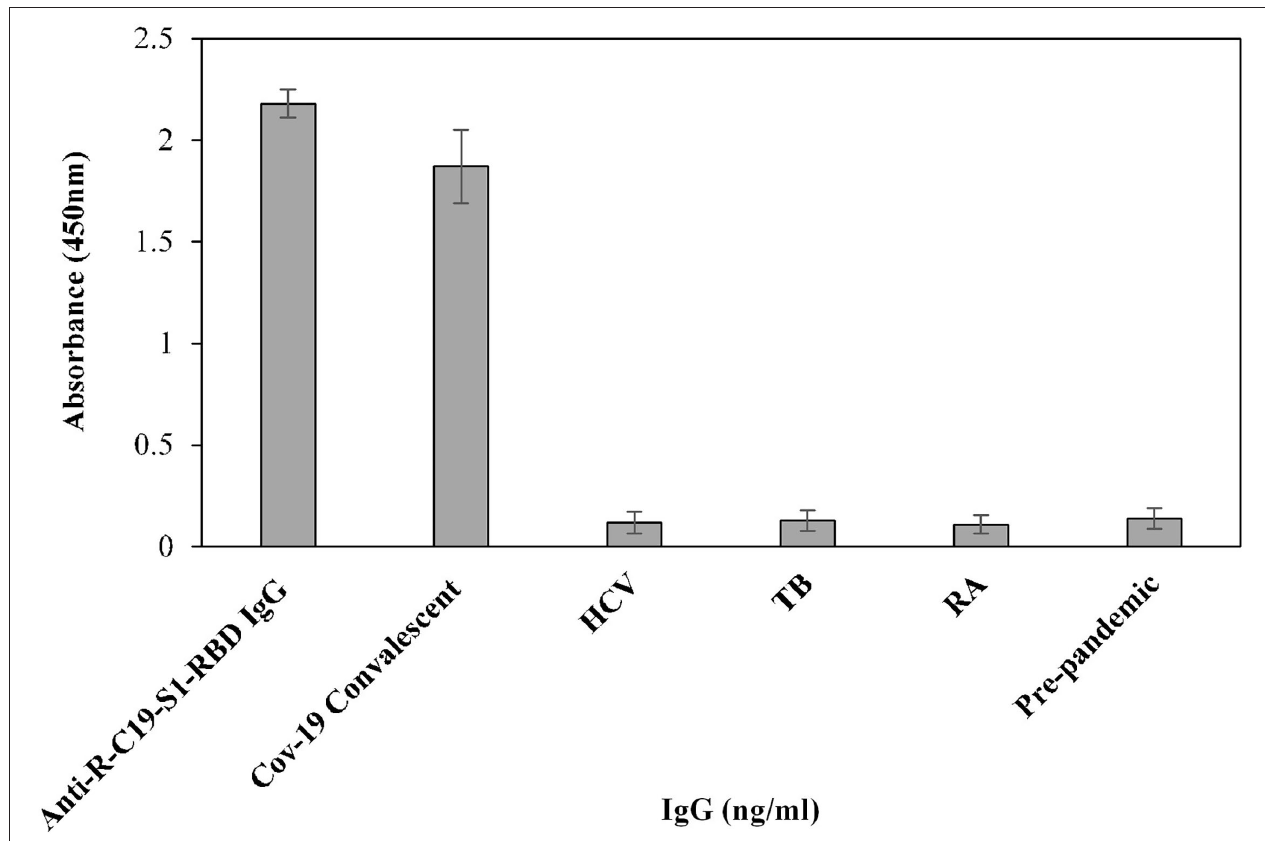
FIGURE 5 | The specificity of the indirect binding ELISA was established by screening three serum samples each from COVID-19 convalescent, HCV, TB and RA patients. Anti-S1-RBD-IgG and pre-pandemic subjects ( n = 3) were used as positive and negative controls,